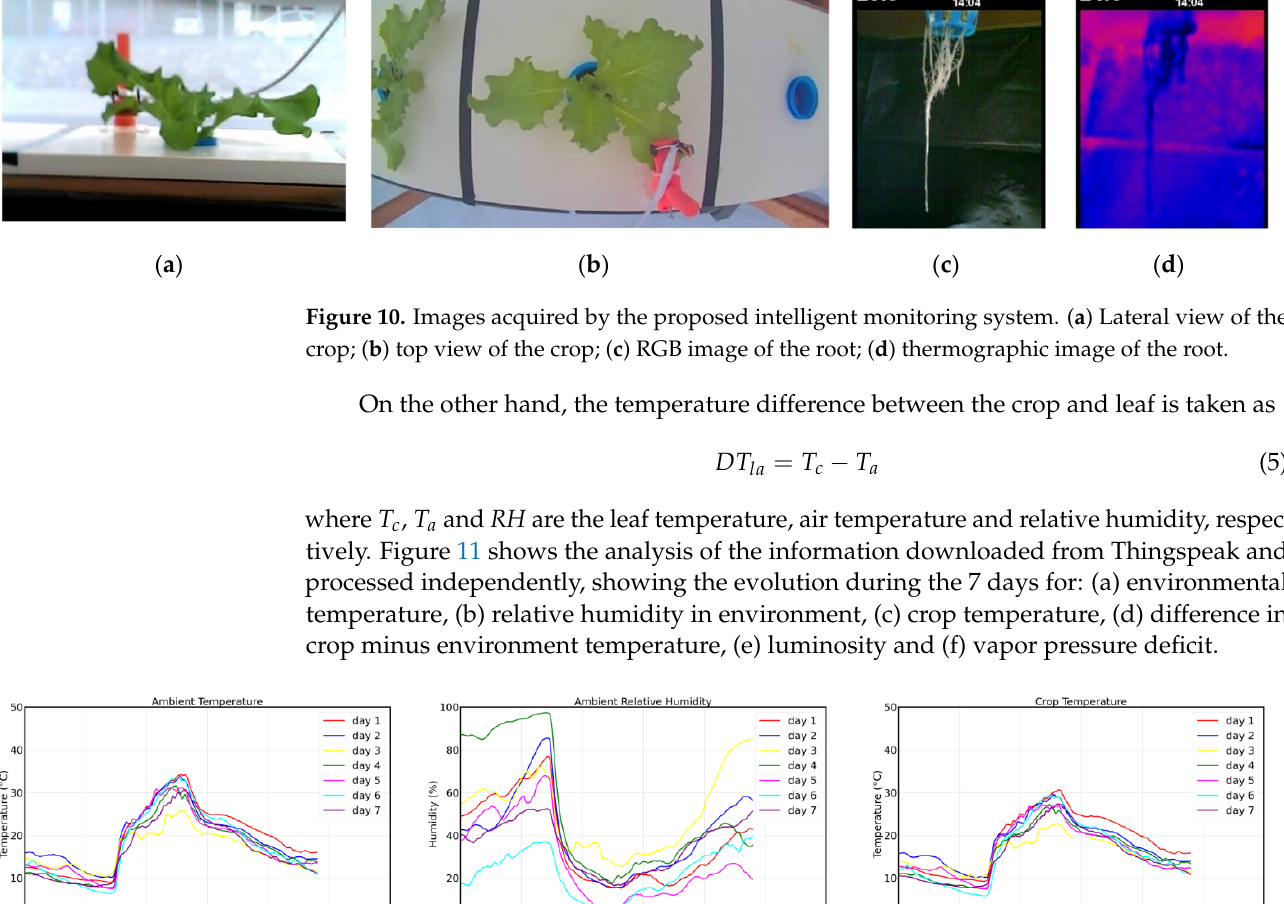
Table 4. Analysis of main variables in the proposed intelligent monitoring system.